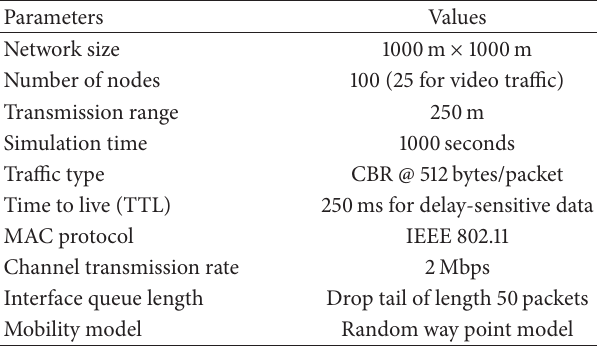
Table 2: Simulation parameters.